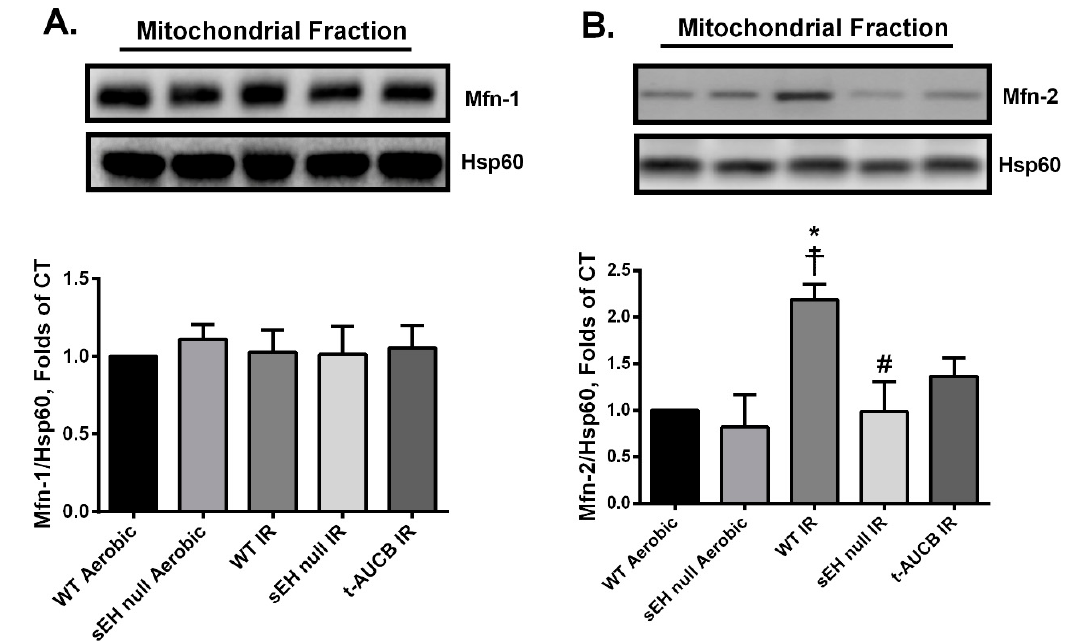
Figure 6. Effect of genetic deletion of Ephx2 or pharmacological inhibition of sEH on the post-ischemic expression of mitochondrial mitofusins (Mfns). Representative immunoblot and densiometric quantification of the mitochondrial expression of ( A ) Mfn-1 and ( B ) Mfn-2 proteins in mice hearts following 30 min ischemia and 40 min reperfusion. Values represent mean ± SEM, * p < 0.05 vs. WT Aerobic CT, ☨ p < 0.05 vs. sEH null Aerobic, # p < 0.05 vs. WT IR ( n = 3 – 4 per group).